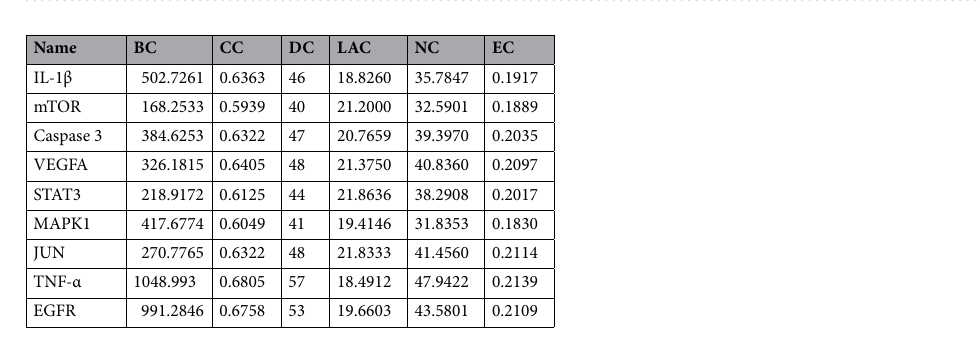
Table 2. The 9 core targets of detailed information on the screening. BC Betweenness centrality, CC Closeness centrality, DC Degree count, LAC Local Average Connectivity-based, NC Network centrality, EC Eigenvector